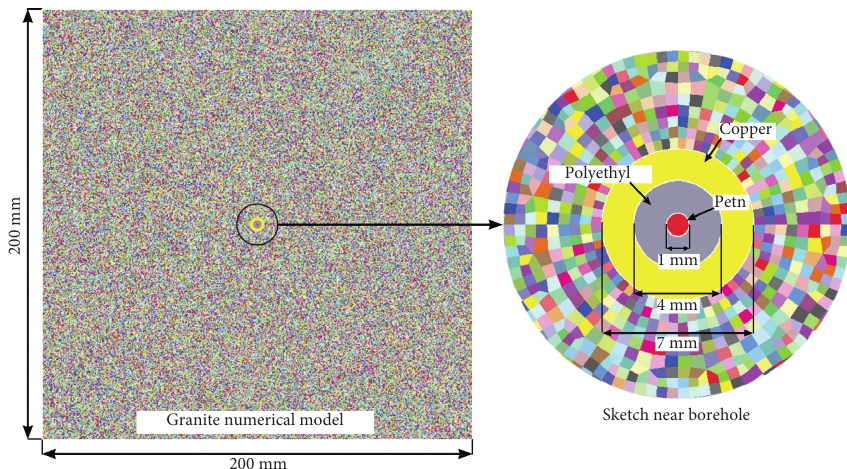
Figure 3: Numerical models proposed in this article.